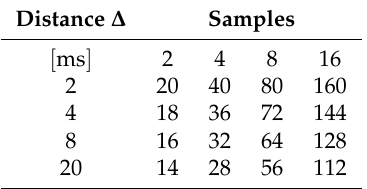
Table 5. Example signature